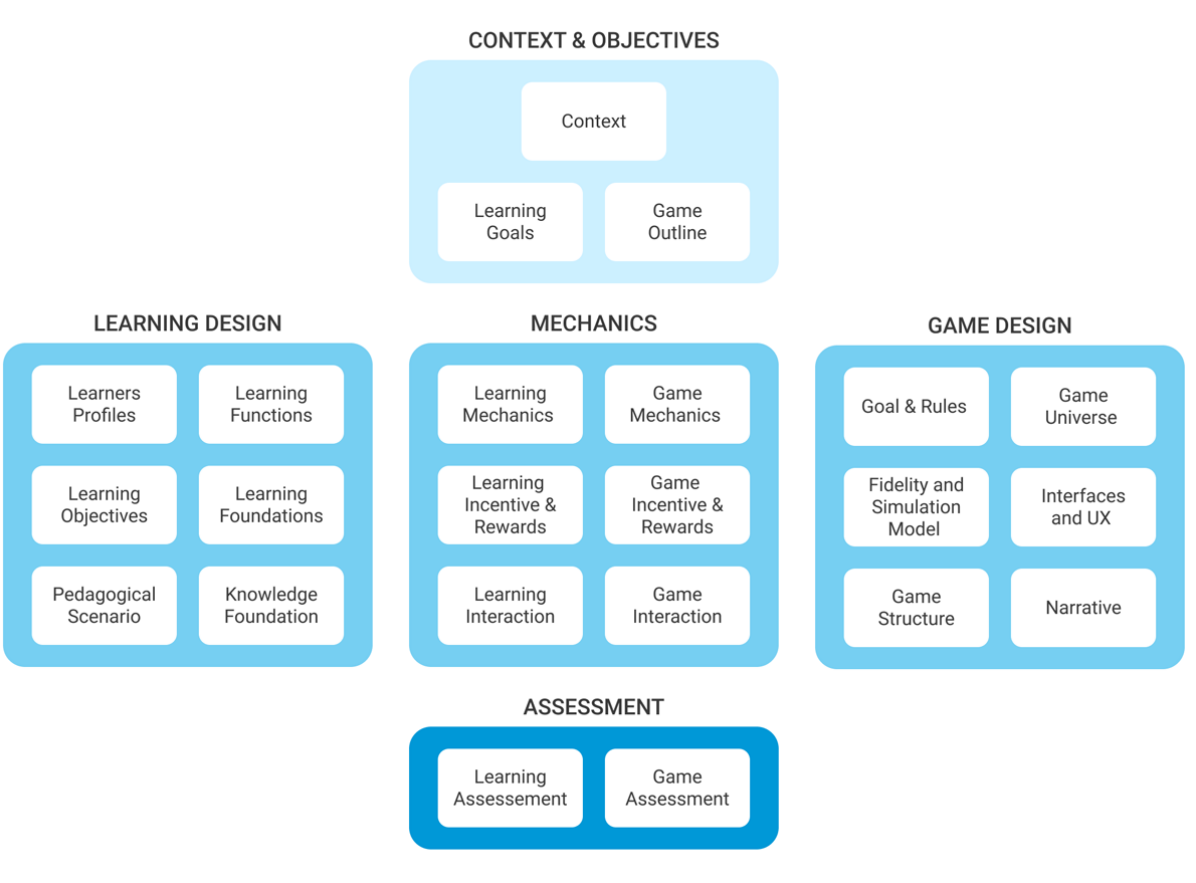
Figure 1. The co.LAB framework with its 5 categories and 23 basic building blocks. Building blocks can be added, adapted or removed according to the serious game design